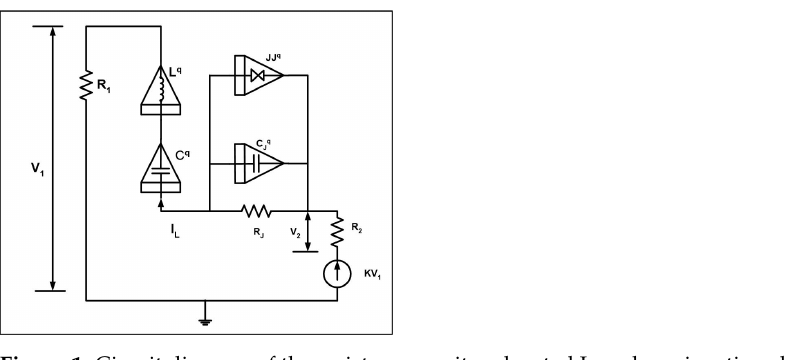
Figure 1. Circuit diagram of the resistor–capacitor shunted Josephson junction chaotic oscillator. The fractional order Josephson Junction and junction capacitor, respectively, are denoted by the symbols JJ q and C q . The fractional order inductor and capacitor are designated as L q and C q , respectively. R 1 , J R 2 and R J are